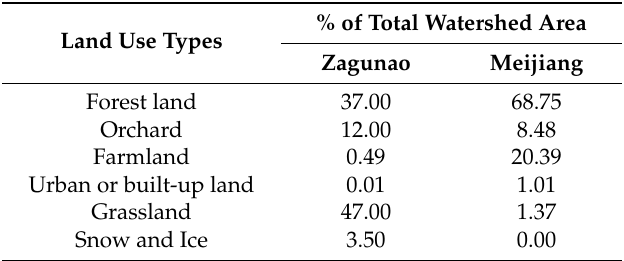
Table 2. Land use/cover in the study watersheds.